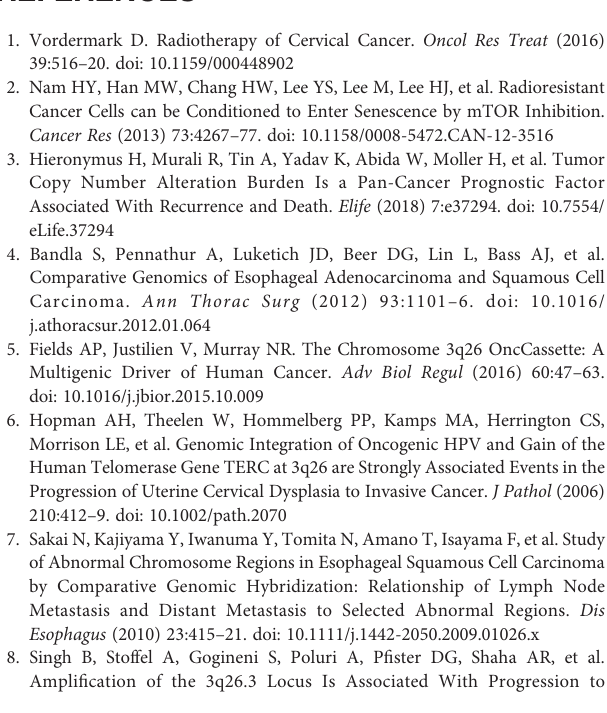
con and shRNA-PRKCI or ov-con and ov-PRKCI in HeLa and SiHa cells without radiation was determined by immuno fl uorescence assays. Scale bars are shown. Supplementary Figure 5 | (A) AF affect the cell viability of HeLa and SiHa cells treated with radiotherapy at 0Gy as shown by CCK-8 assays. (B) The cell viability of AF-treated HeLa and SiHa cells with and without irradiation by CCK-8 assays. Data are shown as the mean ± SD. Data are shown as the mean from three independent